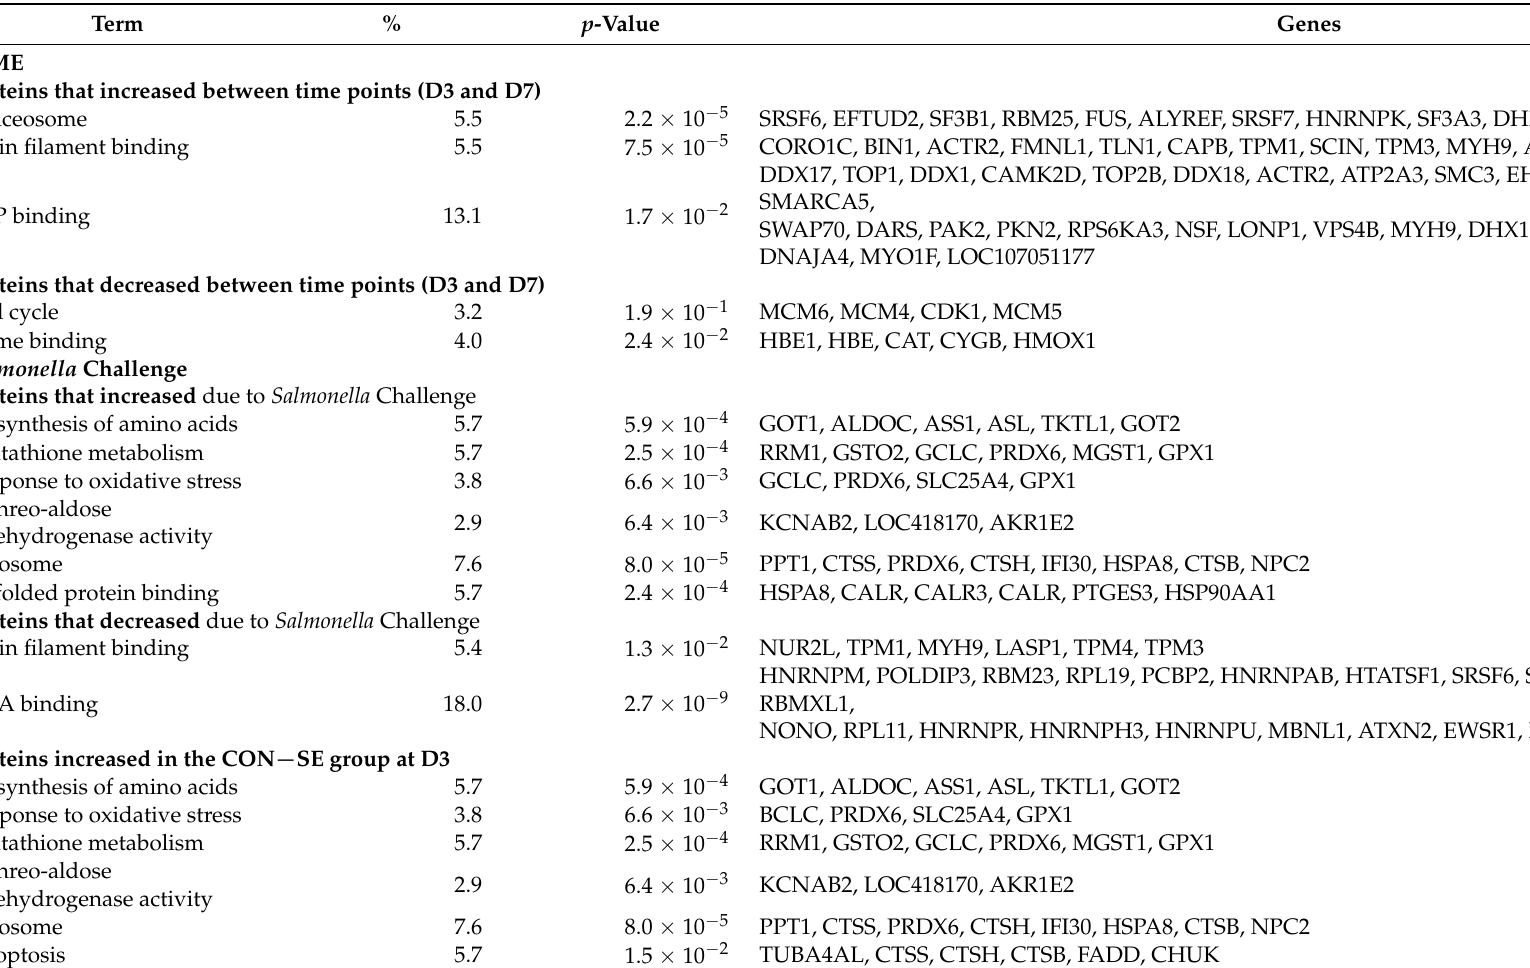
Table 3. Representative categories enriched with differentially abundant proteins between timepoints D3 and D7, overall group, CON − SE at D3 and